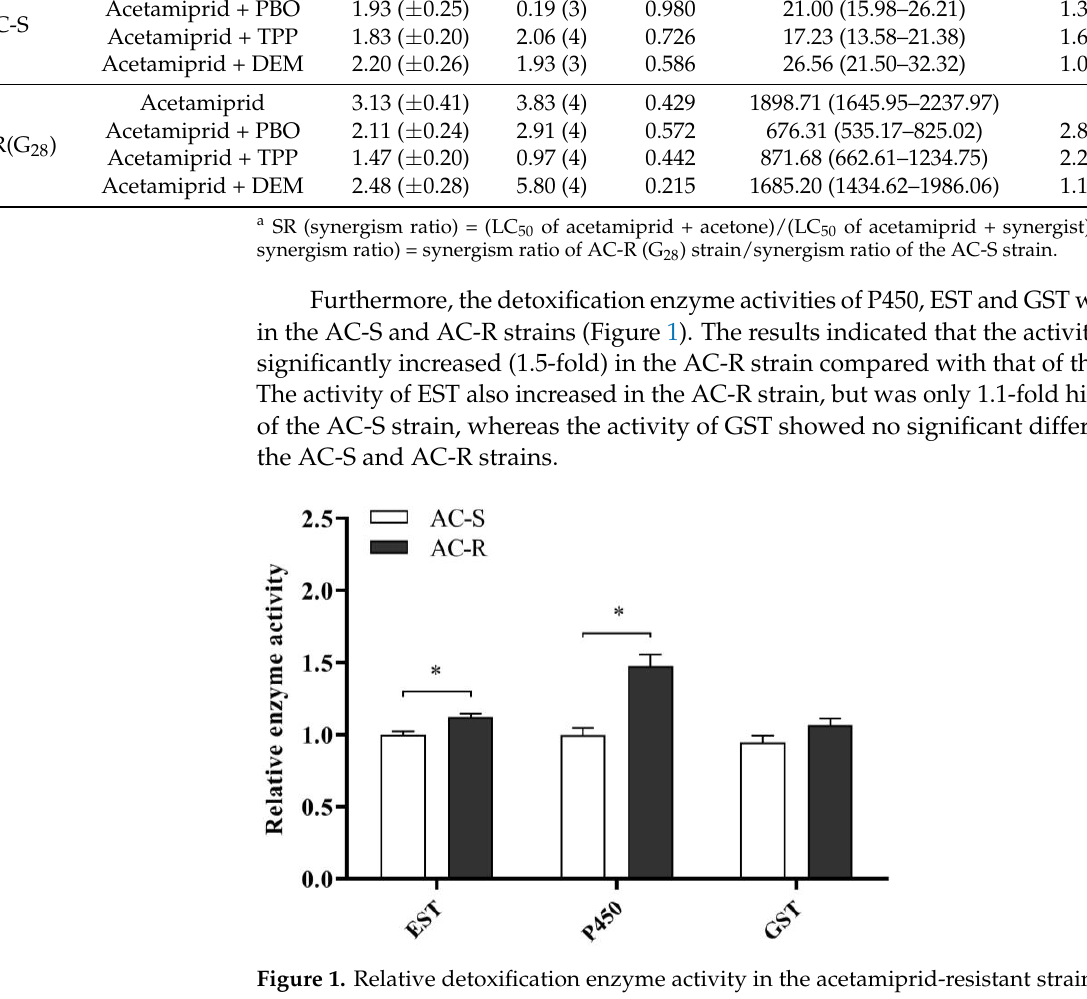
Figure 1. Relative detoxification enzyme activity in the acetamiprid-resistant strain (G 28 ) and sus- ceptible strain (AC-S) of N. lugens. Error bars represent the standard error of the mean. Significant differences between strains were compared with AC-S. * The asterisk indicates significant differences as determined by Student’s t -test ( p < 0.05).